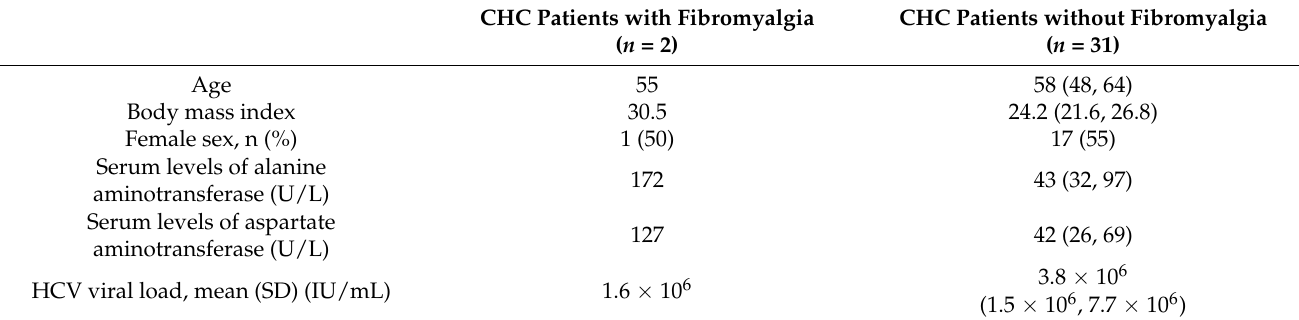
Table 2. Baseline characteristics between CHC patients with and without fibromyalgia.